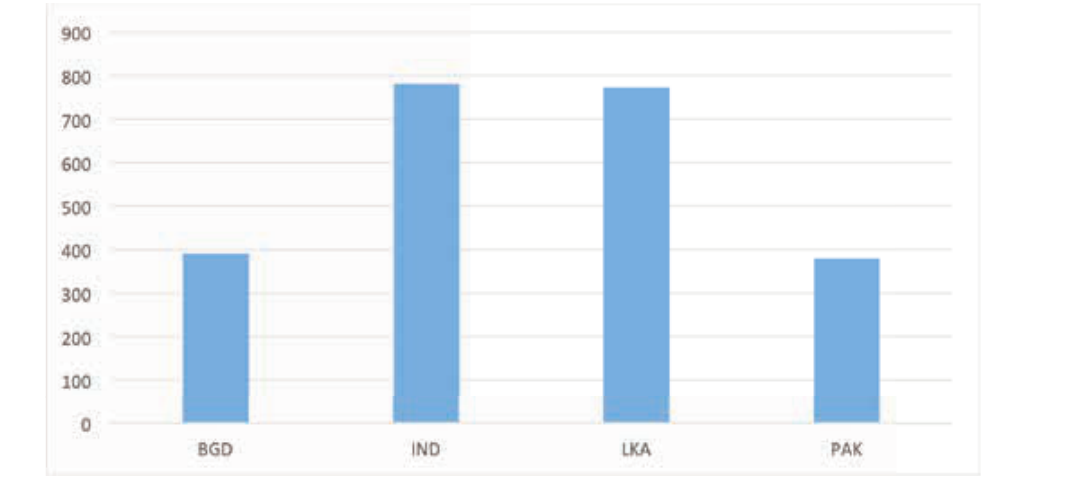
Figure 4: Sum of Governance by